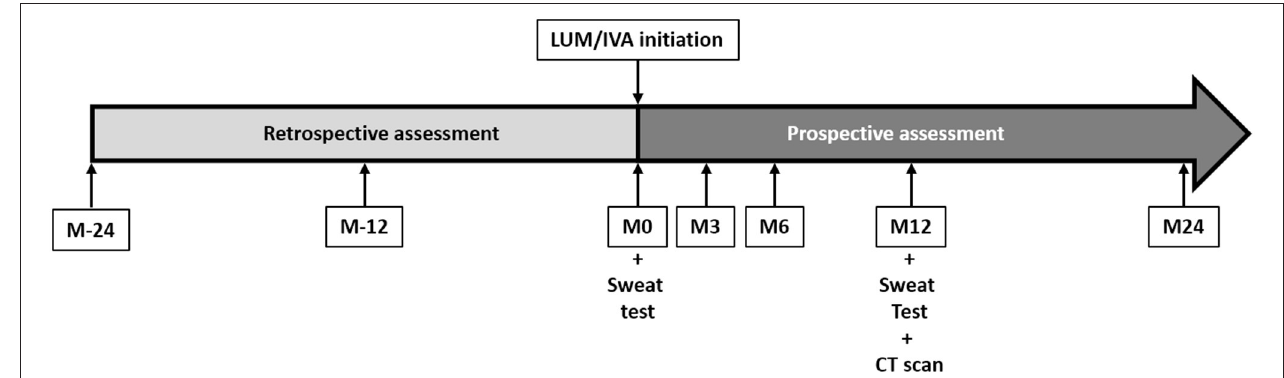
FIGURE 1 | Study design and chronology. Patients were included at the initiation of lumacaftor/ivacaftor (LUM/IVA) (M0). At 3 (M3), 6 (M6), 12 (M12), and 24 (M24) months of treatment, height, weight, body mass index, and lung function testing results were assessed prospectively. These parameters were also assessed retrospectively at 24 (M-24) and 12 (M-12) months before the LUM/IVA initiation. A sweat test was performed at M0 and M12. Computed tomography scans were performed at M12. The side effects of LUM/IVA treatment were assessed at each visit after